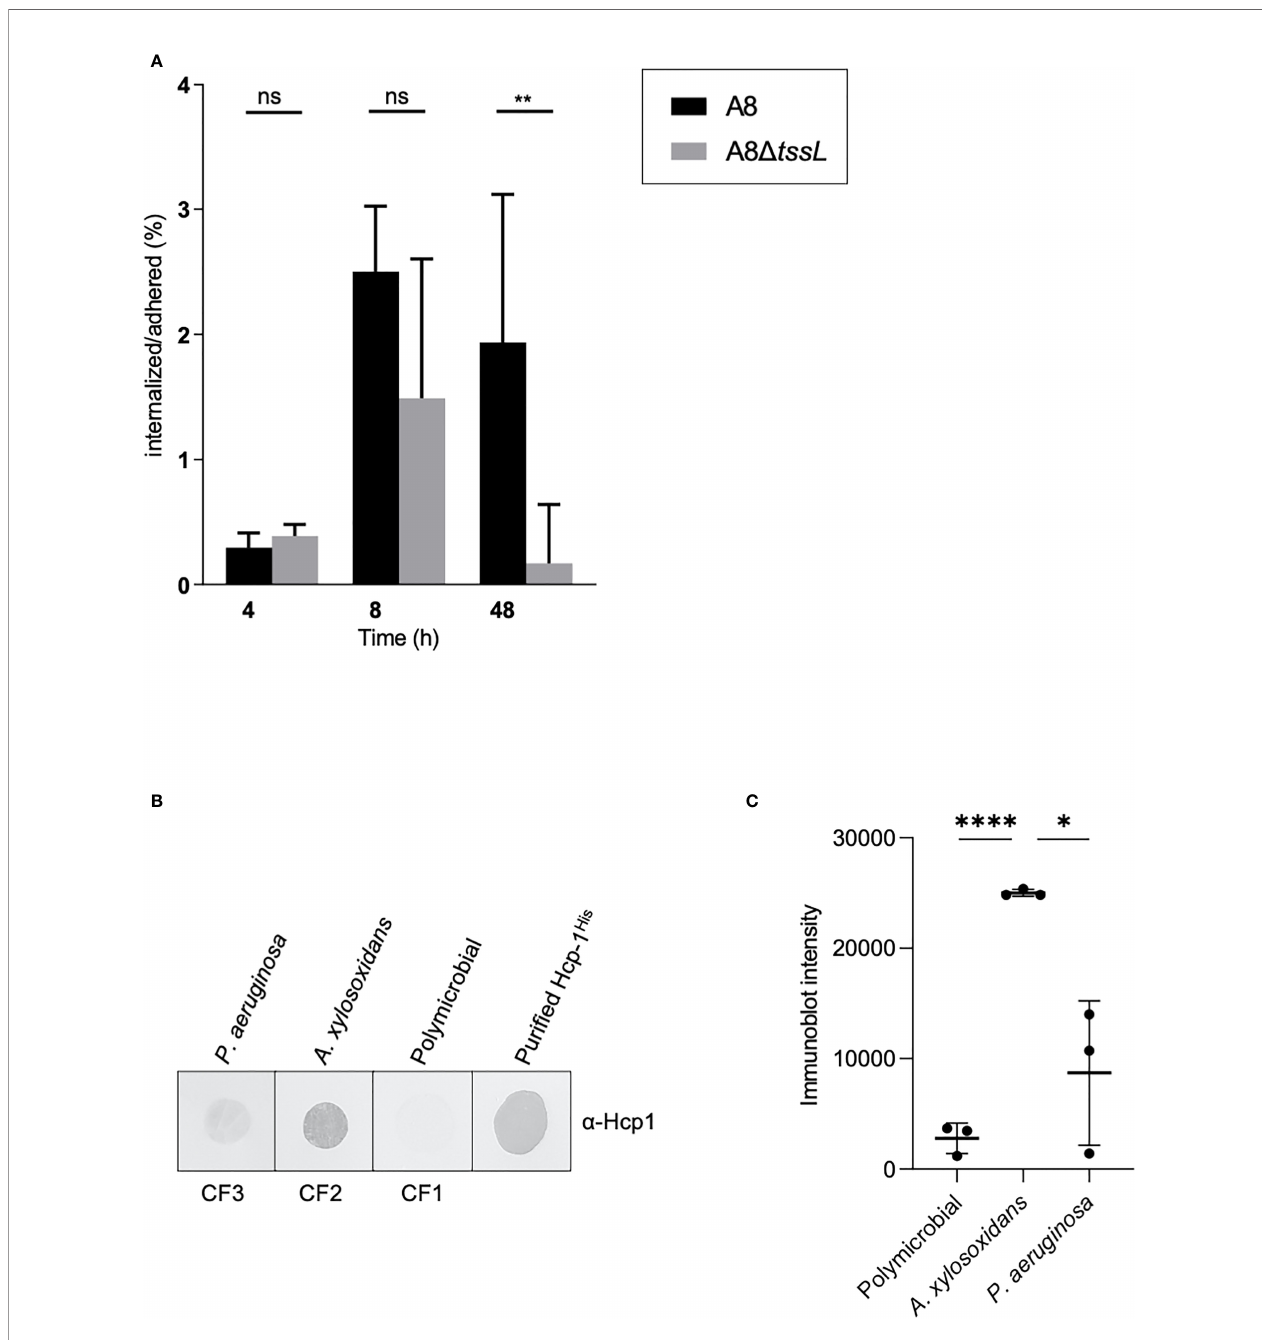
FIGURE 4 | Achromobacter TAX-1 is active during (cystic fi brosis) infections. (A) Percentage of internalized on adhered bacteria of wild-type (WT) A8 and mutant A8 D tssL ( D TSSL) strain on A549 cells after 4, 8, and 48 h of infection at MOI 1:1. Values were expressed as median andinterquartile range. Comparison groups were analyzed with the nonparametric Mann – Whitney test. ** p < 0.01; ns, no signi fi cance. (B) Immunoblot of sputum from a patient with CF infected with either A xylosoxidans (CF2), P. aeruginosa (CF3), or with a commensal fl ora (CF1) analyzed with Hcp-1 antiserum. Puri fi ed Hcp-1 His protein served as positive control. (C) Immunoblot of sputum from a patient CF infected with either A xylosoxidans and P. aeruginosa or with a commensal fl ora were analyzed with Hcp-1 antiserum and quanti fi ed using ImageJ software. Horizontal bars represent the mean and error bars represent the standard deviation of n = 3 different sputums. Statistical signi fi cance was determined by a Student ’ s unpaired t -test. (**** p < 0.0001; * p =